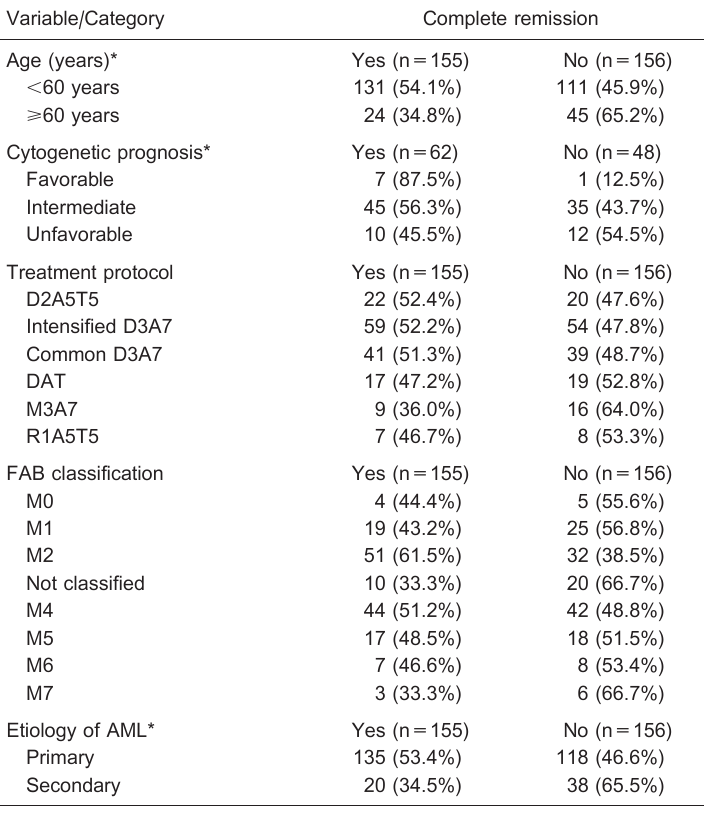
Table 2. Distribution of age, cytogenetic prognosis, treatment protocol, FAB classification, and etiology of AML regarding complete